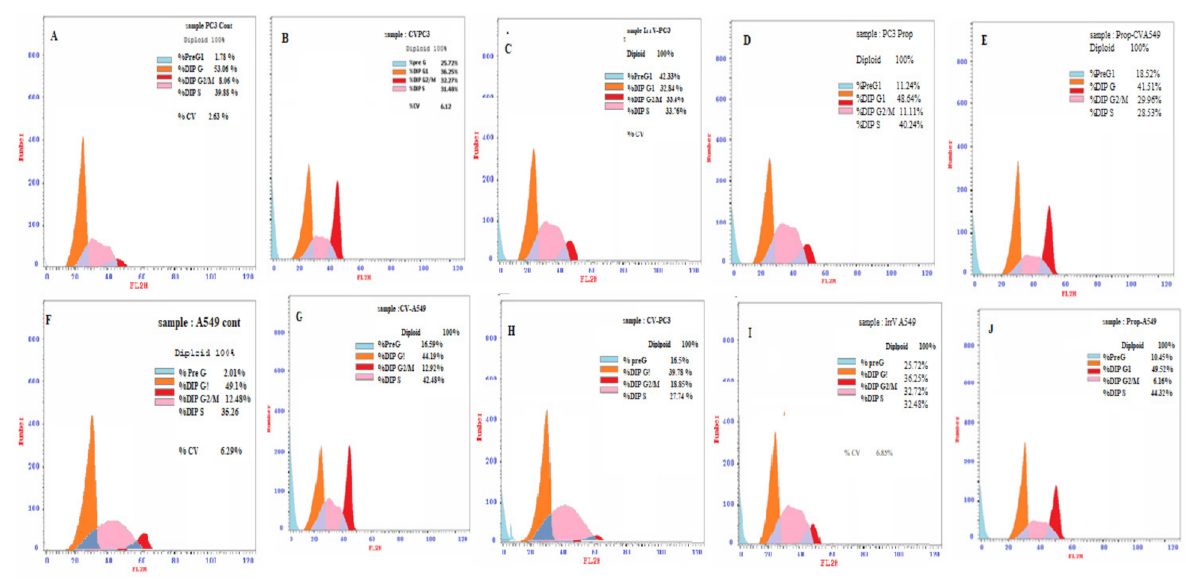
Figure 4. ( A – J ) Evaluation and DNA content and cellular apoptosis post [A549] and [PC3] cell treatment with PEE, CV, IRRV and PEE-CV mix using flow cytometry analysis.